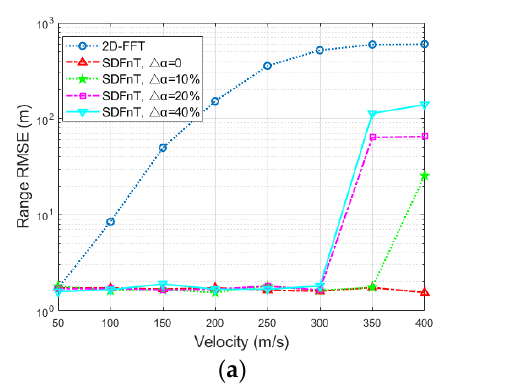
Figure 6. Single-target results in terms of velocity ( a ) RMSE for the range estimation ( b ) RMSE for the velocity estimation.